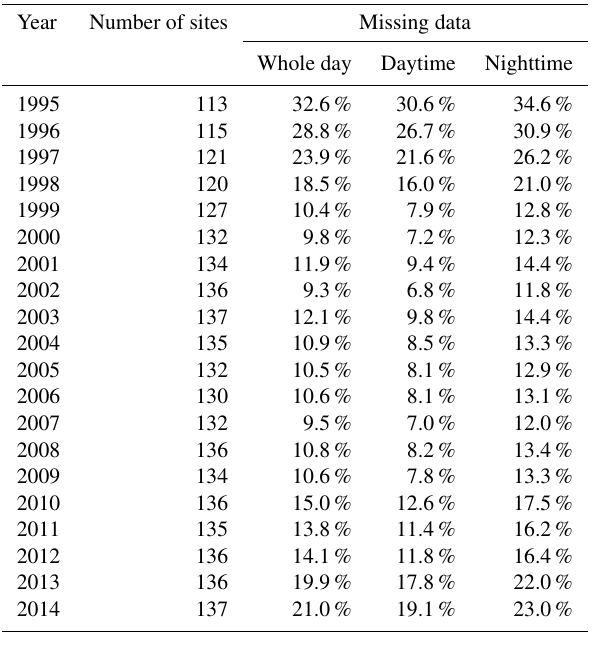
Table 1. Percentage of missing hourly data from each year in the EMEP station